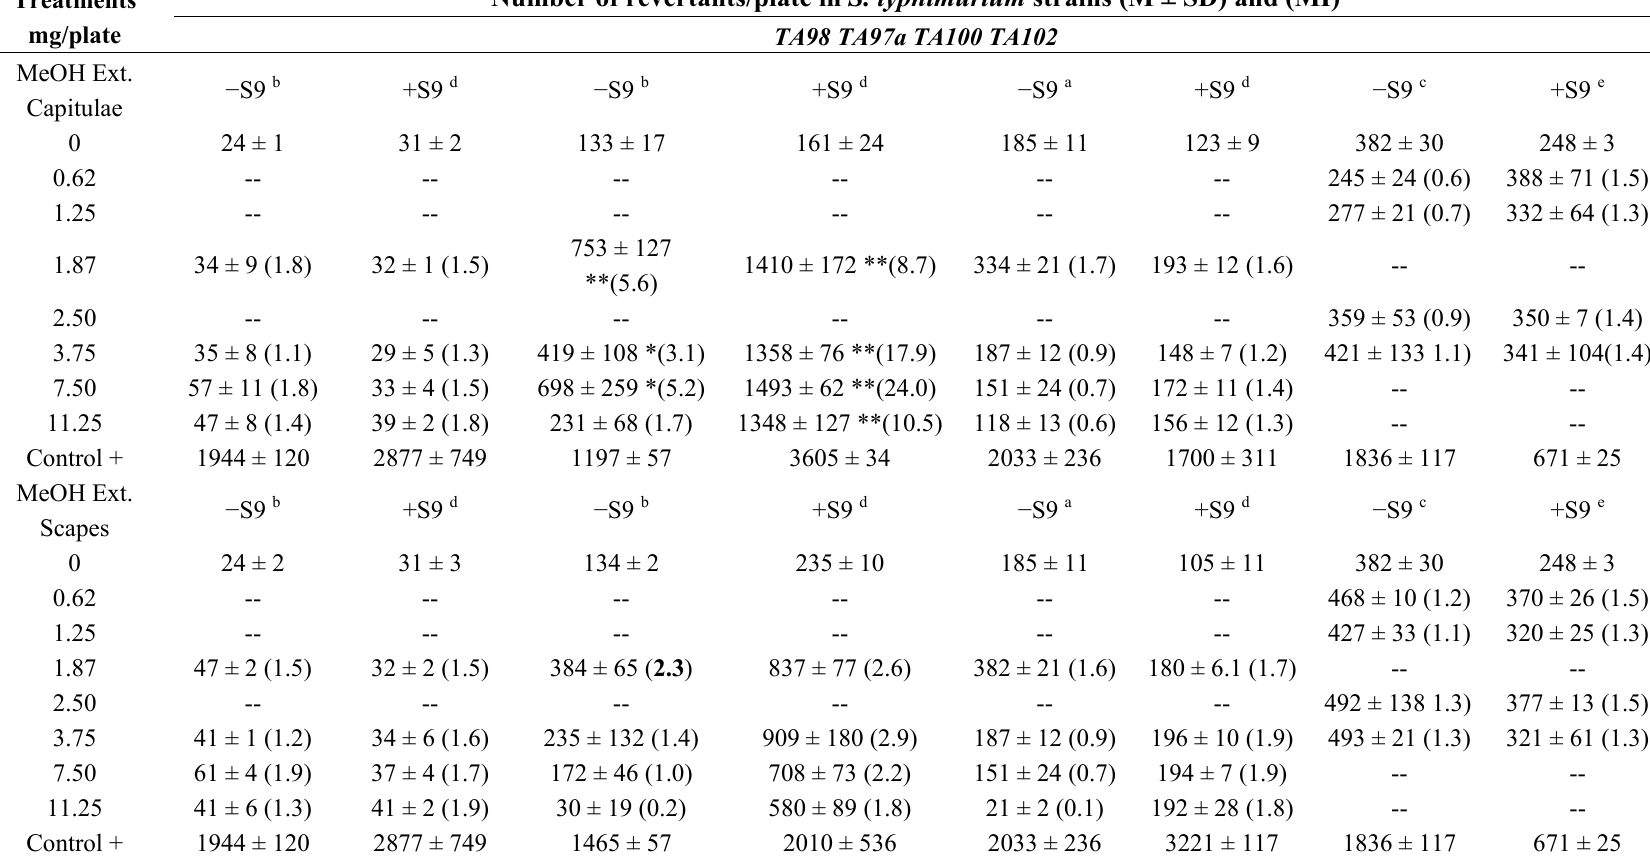
Table 4. Mutagenic activity expressed as the mean and standard deviation of the number of revertants/plate and the mutagenic index (MI), in bacterial strains TA98, TA97a, TA100 and TA102 treated with methanolic extract of capitulae and scapes of P. chiquitensis at various doses, with (+S9) or without ( − S9) metabolic activation. Number of revertants/plate in S. typhimurium strains (M ± SD) and (MI) Treatments mg/plate TA98 TA97a TA100 TA102 MeOH Ext.